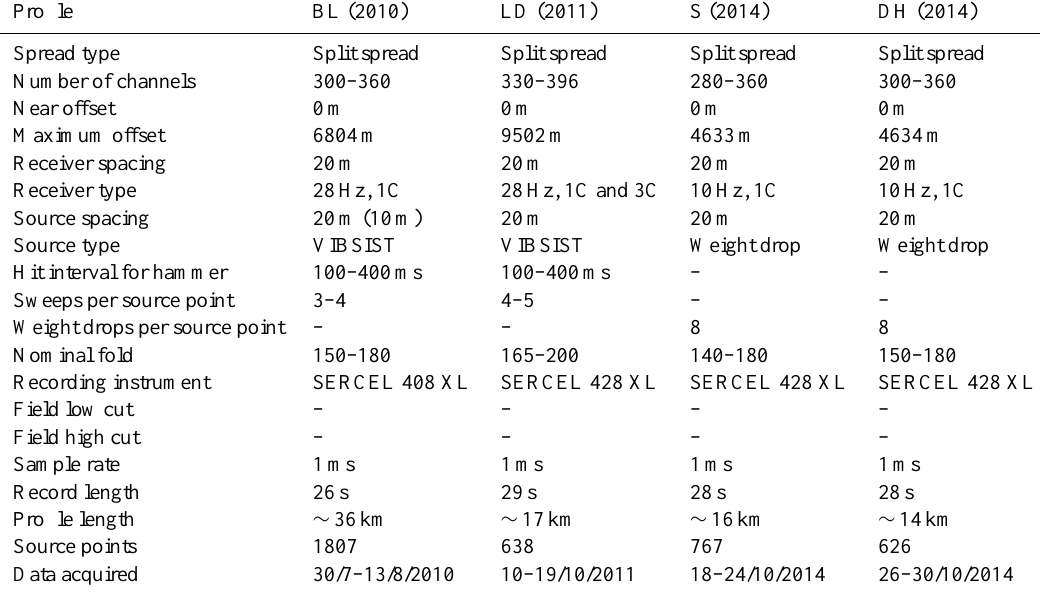
Table 1. Acquisition parameters for the Byxtjärn-Liten profile (BL, 2010), Liten-Dammån profile (LD, 2011), Sällsjö profile (S, 2014) and Dammån-Hallen profile (DH,